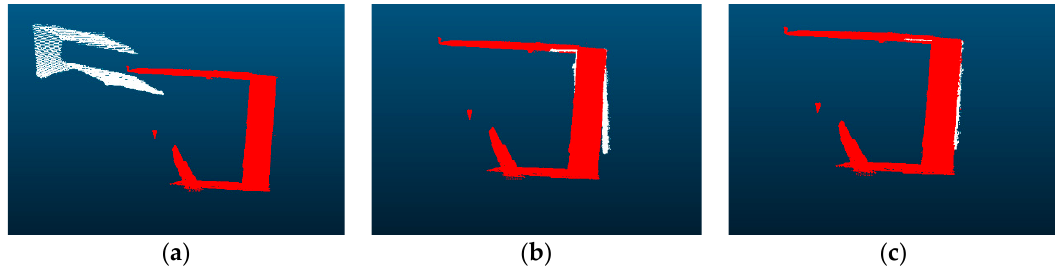
Figure 5. LiDAR point cloud is shown in red and RGB-D point cloud in white. ( a ) Unmatched RGB-D point cloud and LiDAR point cloud, ( b ) matched RGB-D point cloud and LiDAR point cloud using deep learning, and ( c ) matched RGB-D point cloud and LiDAR point cloud using inductively coupled plasma (ICP) with initial value from deep learning.